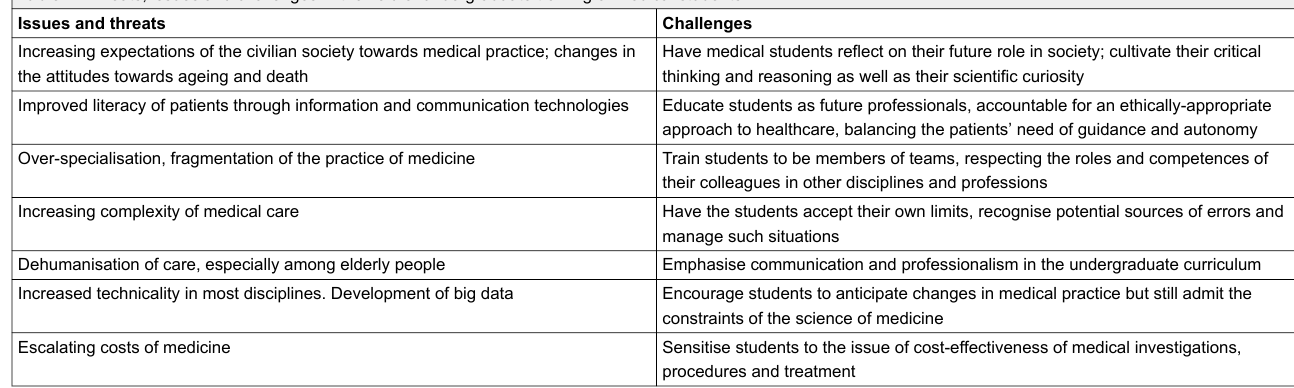
Table 1: Threats, issues and challenges in the field of undergraduate training of medical